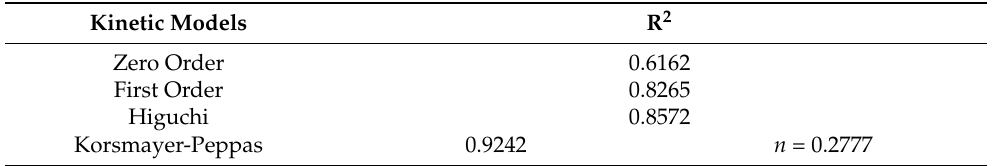
Figure 6. Cumulative drug release from pure APL suspension, optimized NEs (ANE4) APNE4- loaded gel. Table 2. Drug release kinetic models.